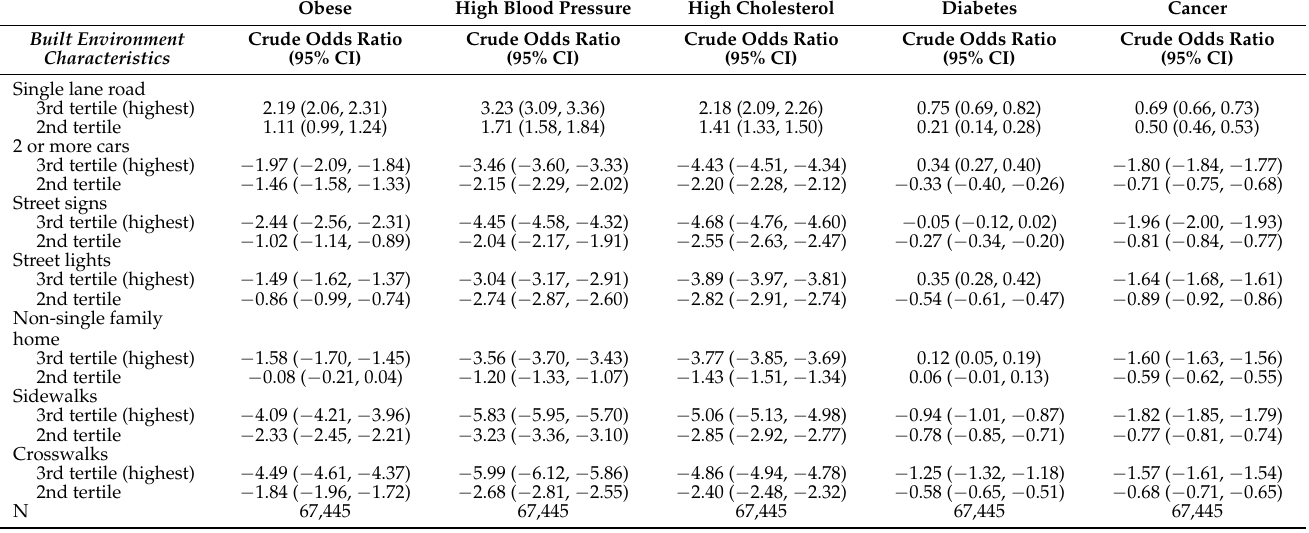
Figure 5. Geographic distribution of sidewalks across census tracts in three metropolitan areas. ( A ) Washington DC, ( B ) San Diego, California, ( C ) Jacksonville, Florida. Darker colors signal higher prevalence of a neighborhood characteristic. Table 2. Built environment predictors of adult health outcomes a .